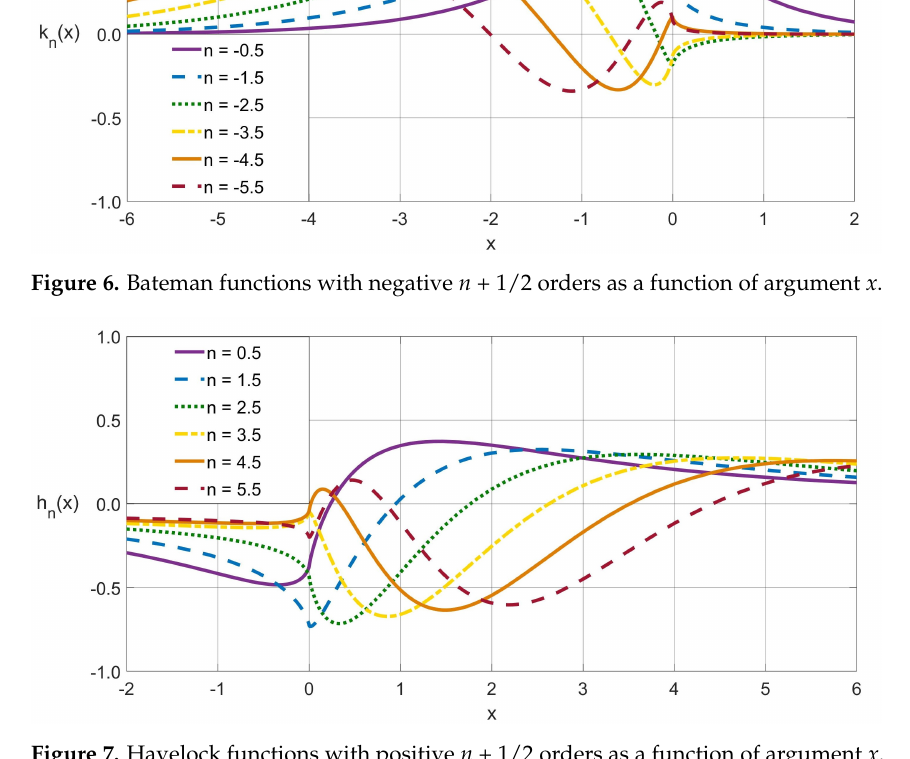
Figure 7. Havelock functions with positive n + 1/2 orders as a function of argument x .